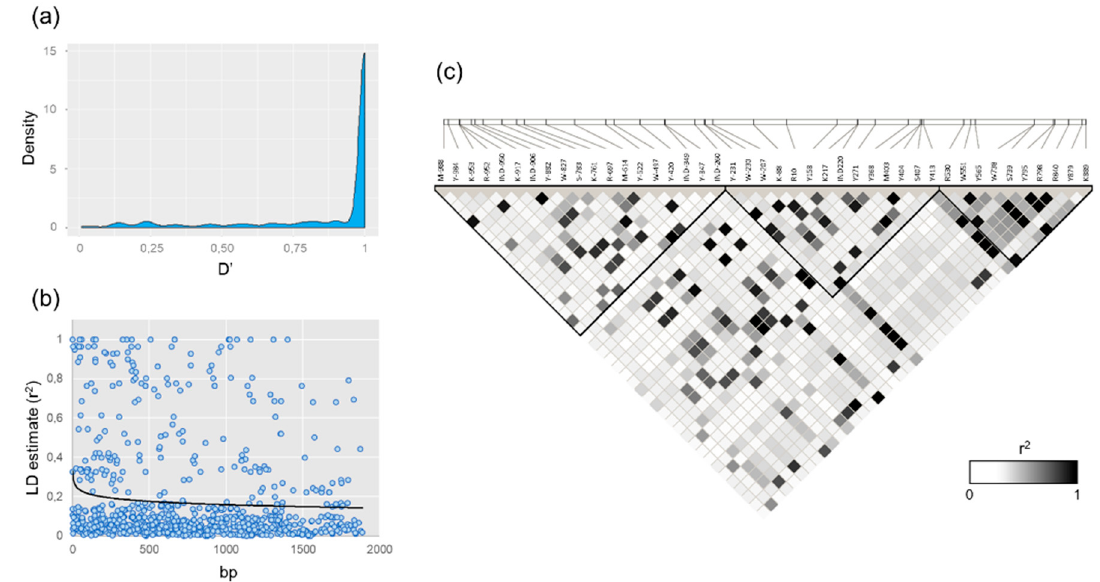
Figure 2. Linkage disequilibrium (LD) evaluation in the VviUCC1 gene. ( a ) Density plot of the pairwise standardized disequilibrium coefficient (D’) obtained for the 43 VviUCC1 polymorphisms detected with a MAF > 0.05. ( b ) LD decay plot, using the squared correlations of allele frequencies ( r 2 ) against physical distance (bp). The black line indicates the first-order logarithmic fitting line. ( c ) LD plot representing the magnitude of pairwise r 2 as a white-to-black gradient (see color code). LD blocks are shown as black triangles.